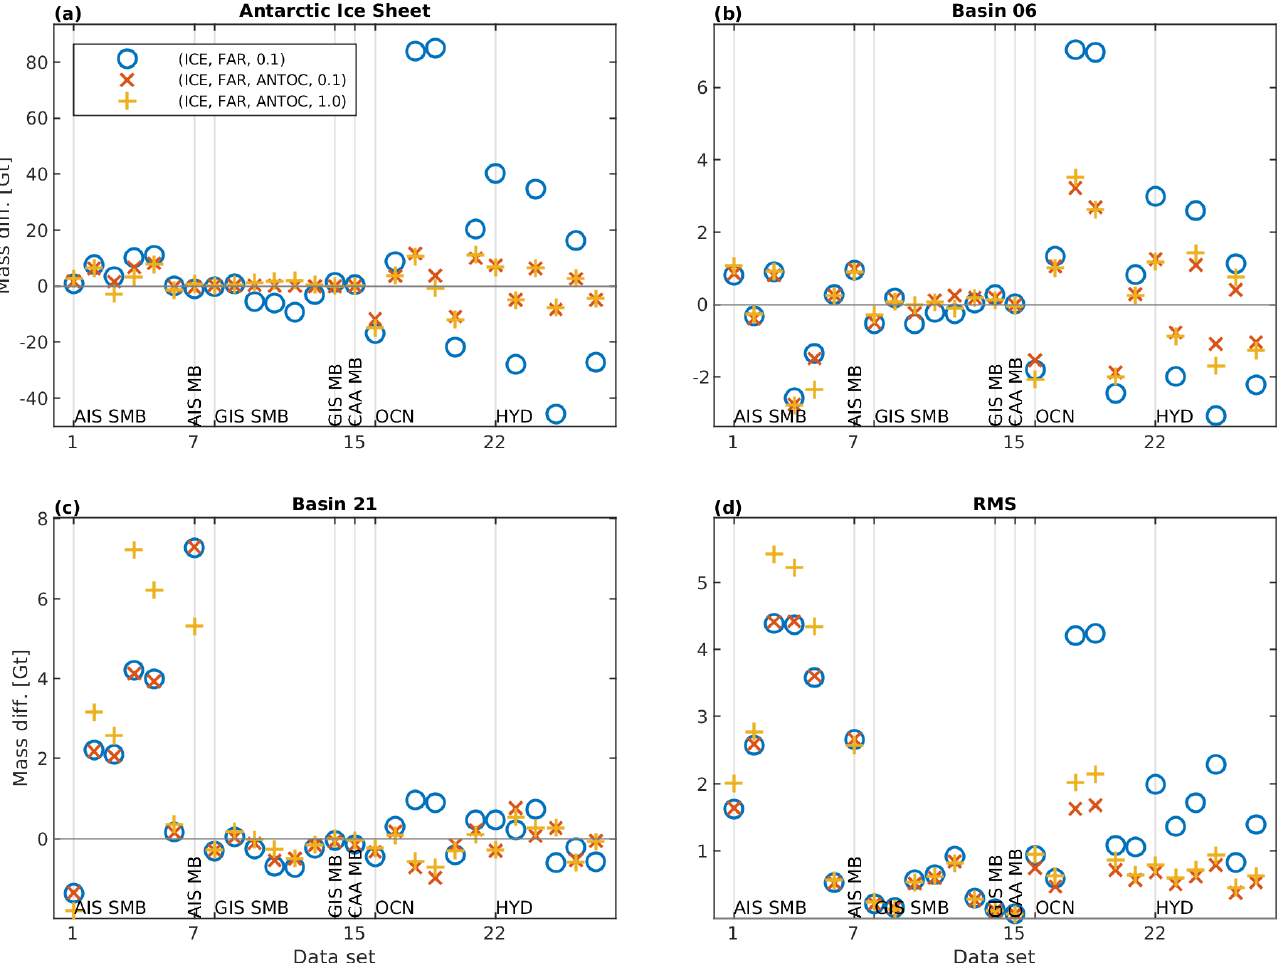
Figure 5. Differences between mass change estimates derived from synthetic data sets (Table 1) and the their corresponding true mass changes for ( a ) the entire Antarctic Ice Sheet, ( b ) Basin 06, ( c ) Basin 21 derived using different realizations of tailored sensitivity kernels and ( d ) the root mean square (RMS) over all basins and aggregations (Figure